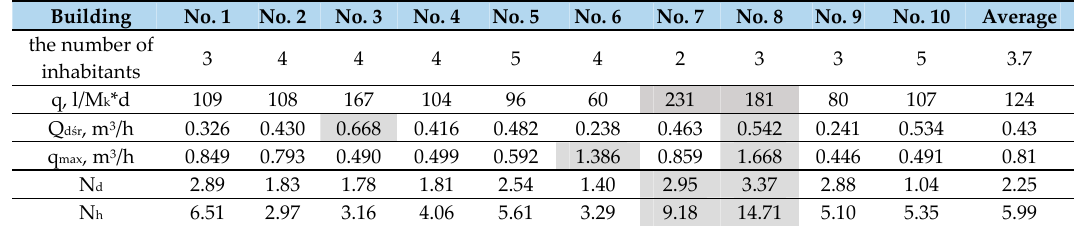
Table 2. results obtained for single-family